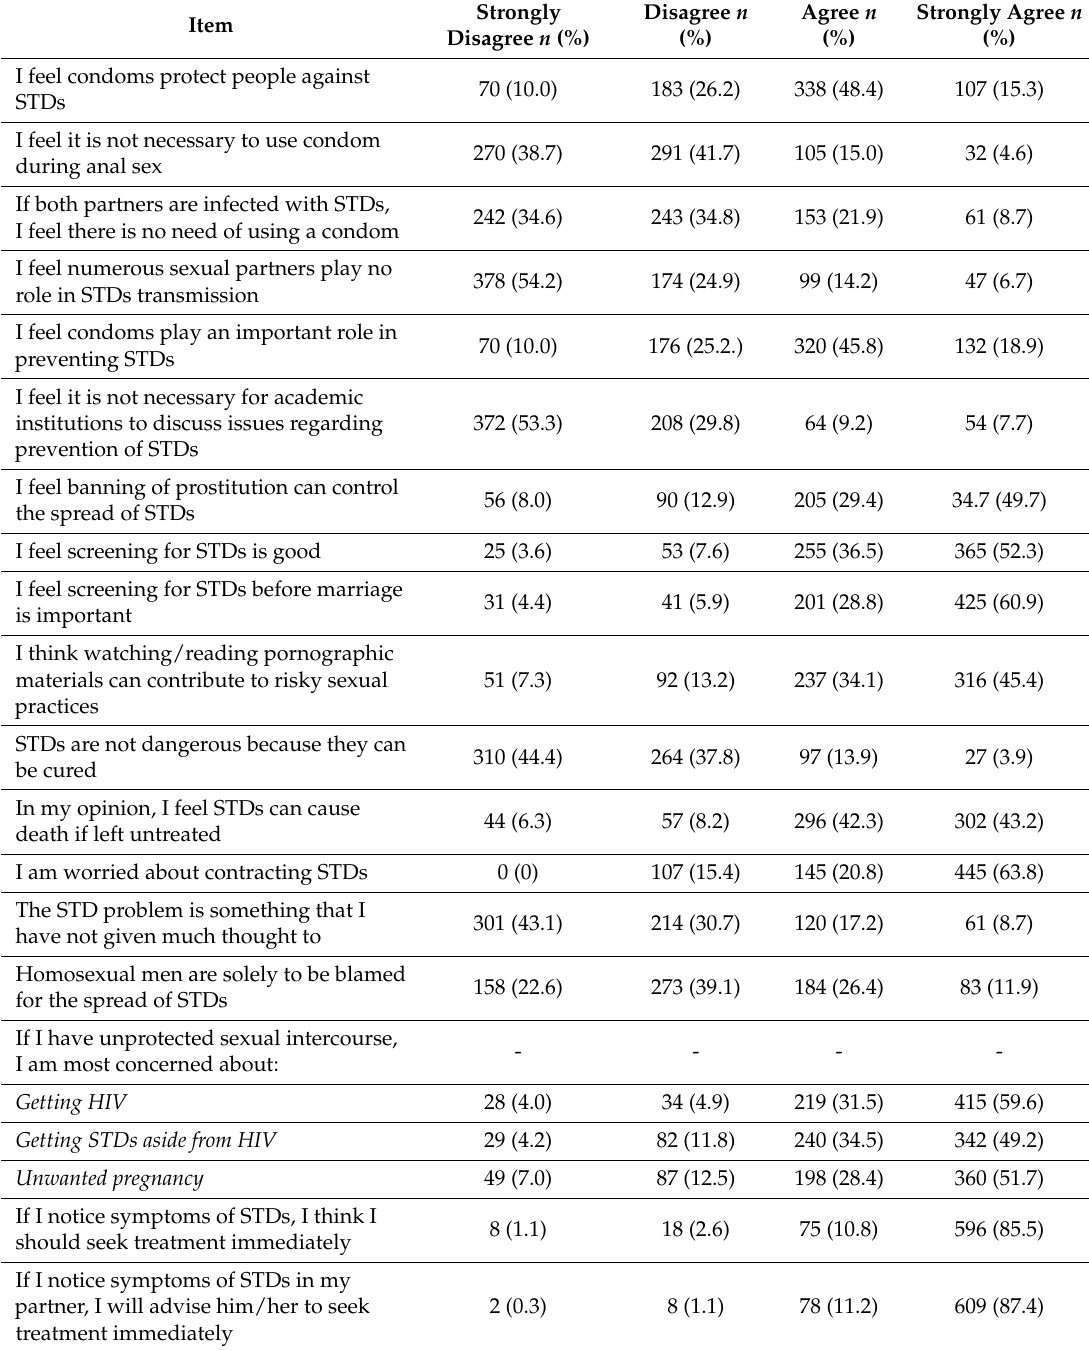
Table 2. Attitudes on sexually-transmitted diseases among university